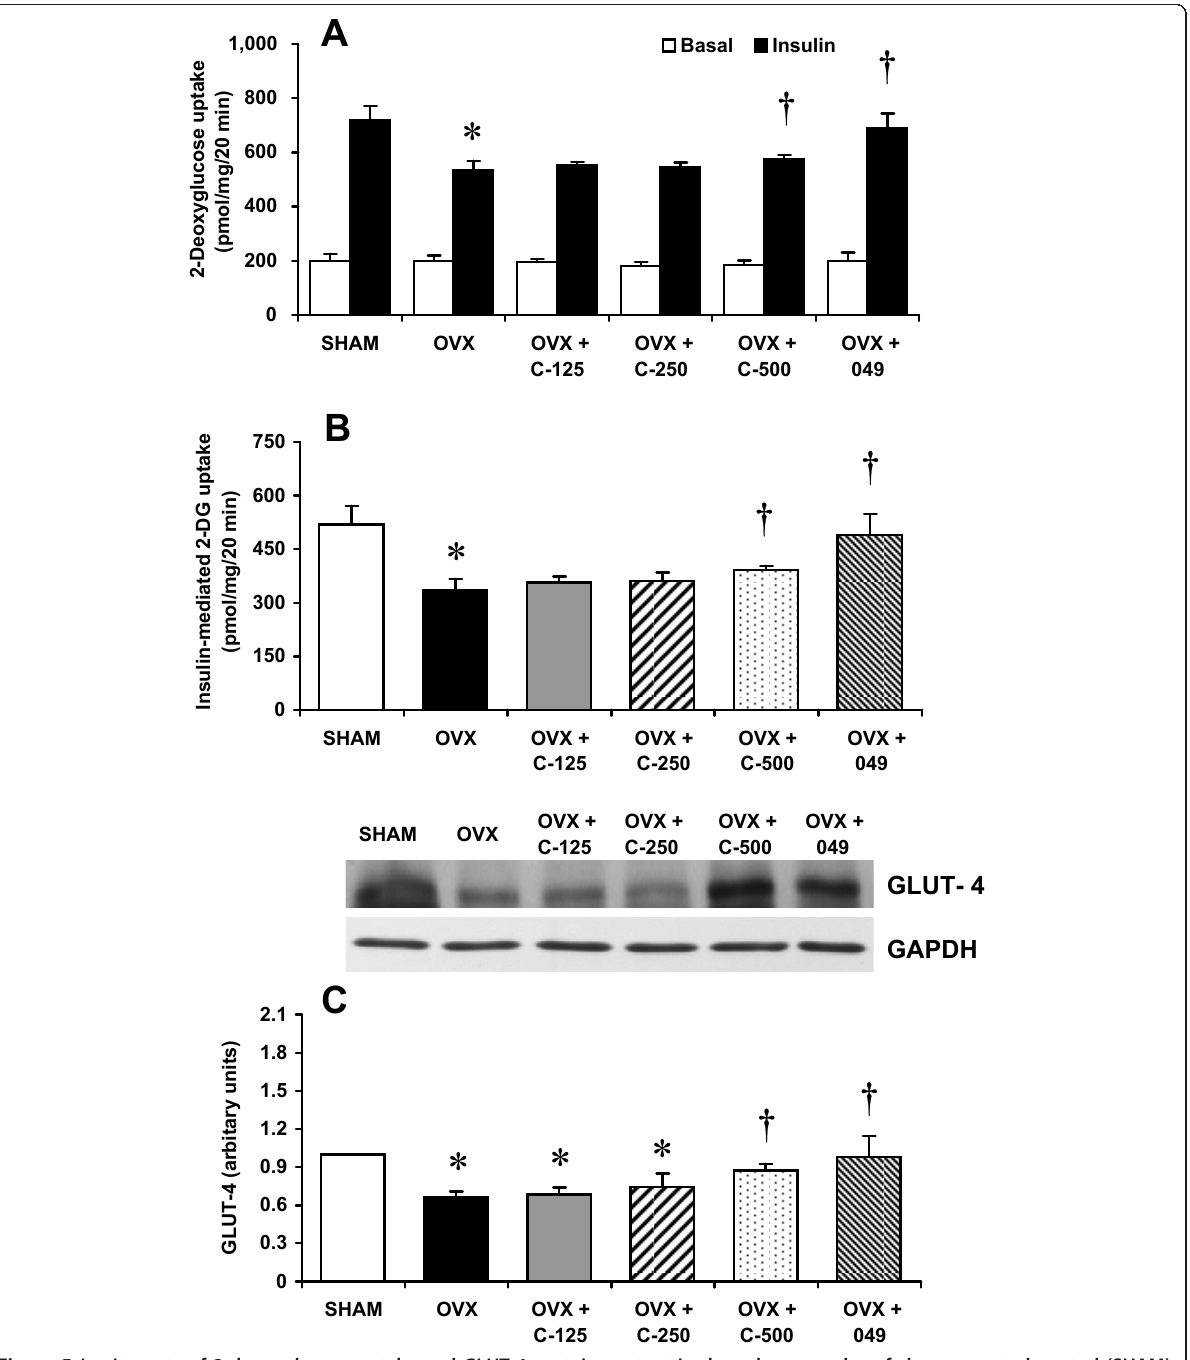
Figure 5 In vitro rate of 2-deoxyglucose uptake and GLUT-4 protein content in the soleus muscles of sham operated control (SHAM) and ovariectomized (OVX) rats treated with or without C. comosa hexane extract or compound 049 . Animals are as described in legend of Figure 2. (A) 2-deoxyglucose uptake in the absence (blank bar) and presence (filled bar) of insulin (2 mU/ml); (B) net increase above basal level for 2-deoxyglucose uptake due to insulin; (C) whole muscle GLUT-4 protein levels. GLUT-4 levels were normalized by GAPDH. Values are reported as the mean ± SE for 7-8 animals/group. * P < 0.05 vs. SHAM group; † P < 0.05 vs. OVX